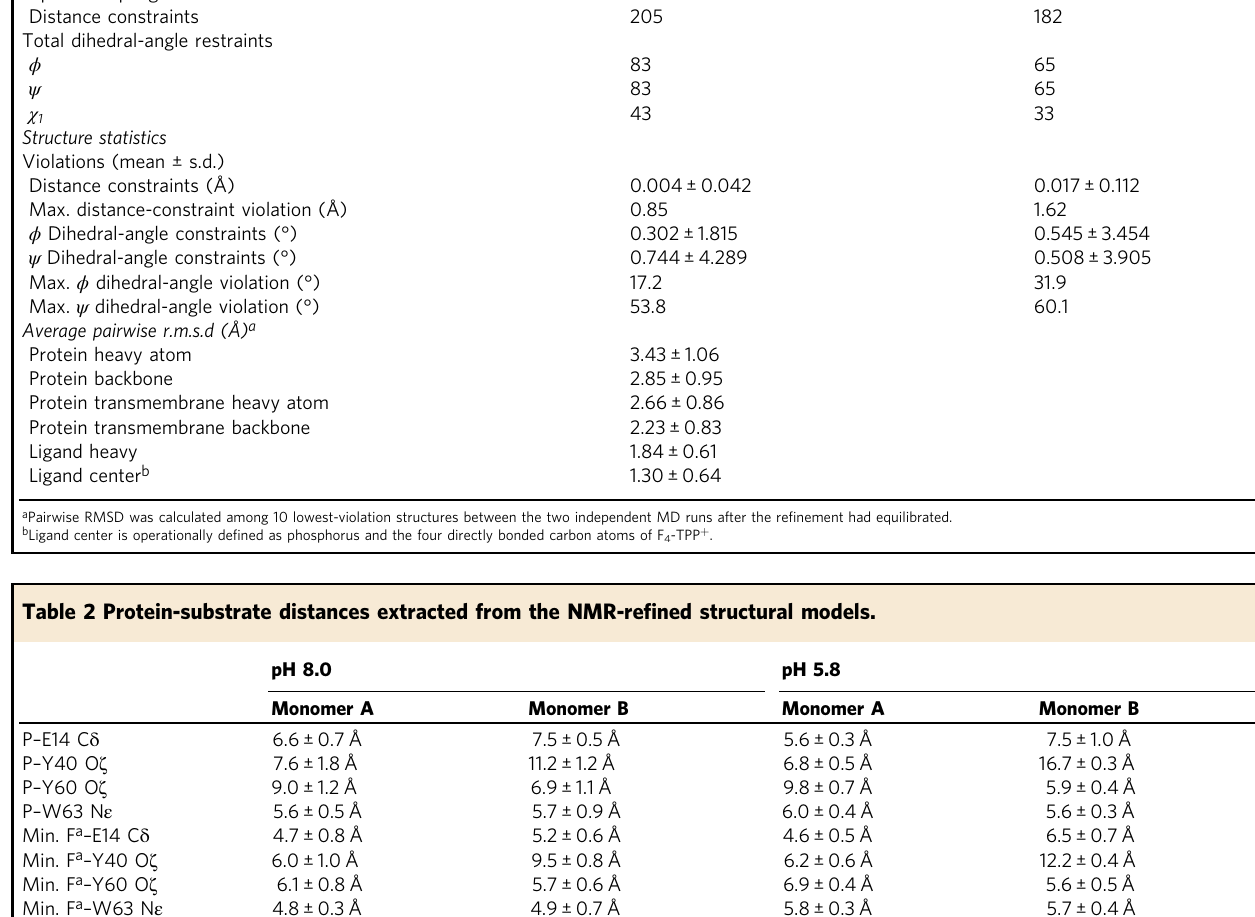
Theaverage distances andstandarddeviationsare from the ensembleof 10 minimumconstraint-violating structuresin the fi nal 240ns of MDtrial 1 and160ns of MD trial2. Prefers toTPP phosphorus atom while protein atom is denoted by standard IUPAC nomenclature. a Distances of the nearest fl uorine to speci fi c protein